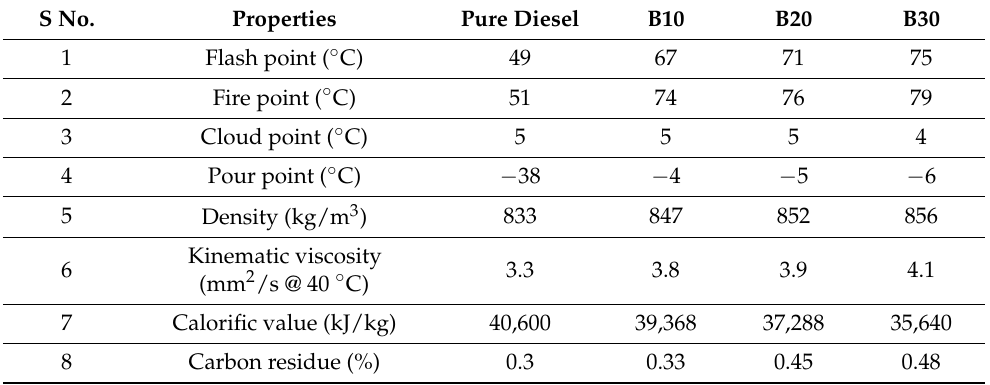
Table 1. Measured Fuel Properties.